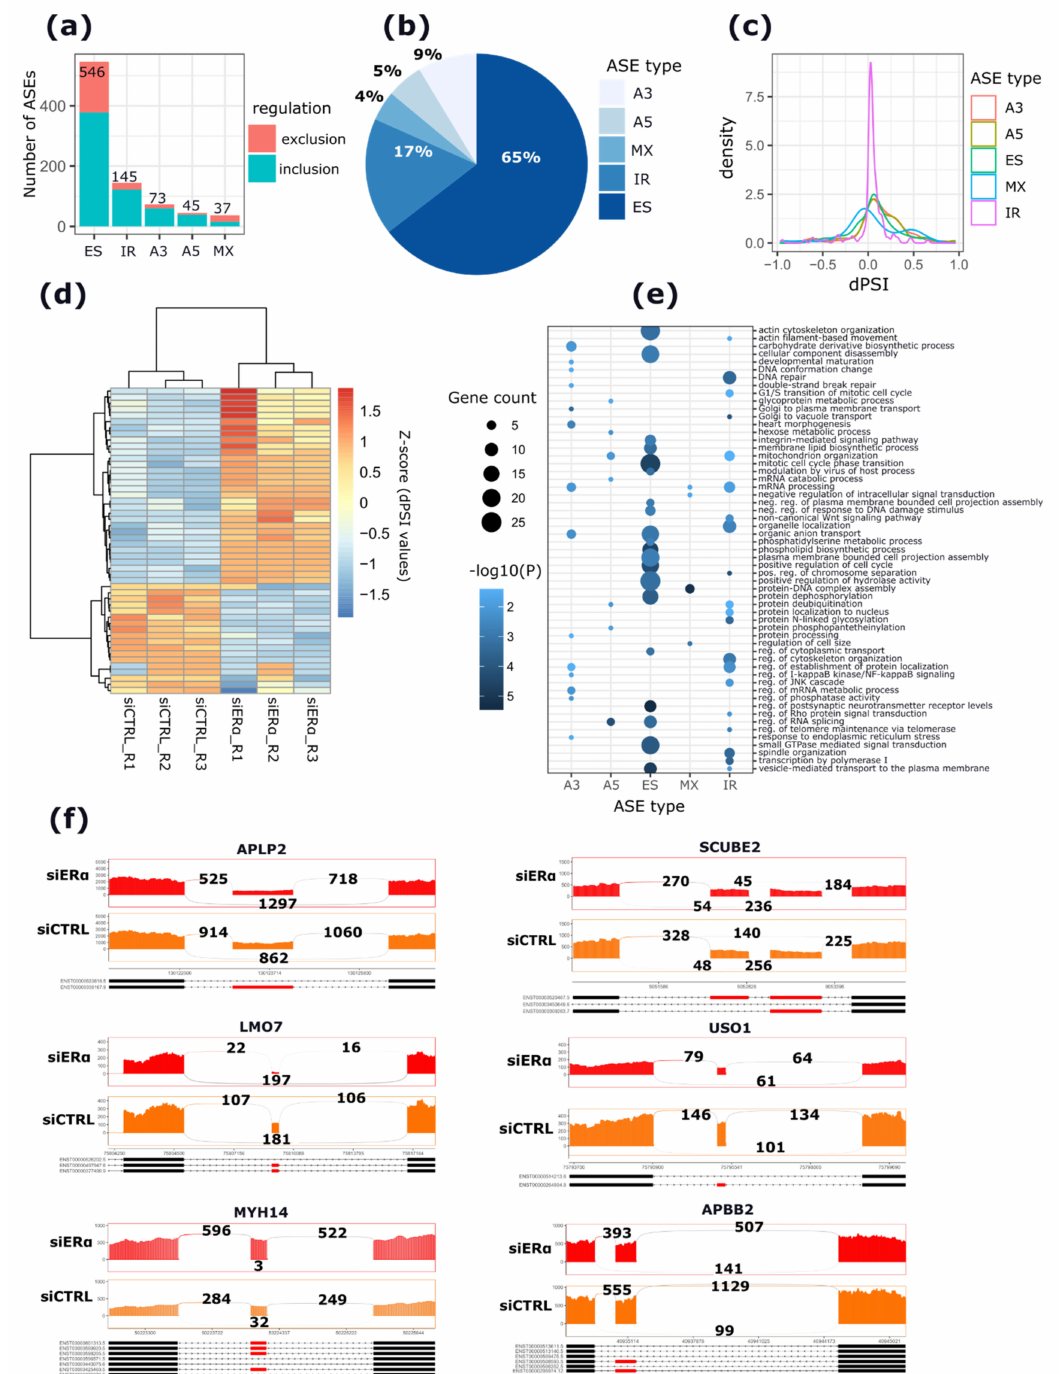
Figure 3. Overview of differential AS changes occurring upon apoER α depletion in MCF-7 cells. ( a ) Stacked bar plot representing the number of significant ASEs for each AS type. Red and cyan colors represent the number of included and repressed ASEs, respectively. ( b ) Pie-chart representing the percentage of ASE types. ( c ) Density plot representing the dPSI of the significant ASEs. ( d ) Heat map reporting the dPSI values of the top 50 significant ASEs. Color bar intensities are proportional to the inclusion level of each event (Z-score). ( e ) Dot plot representing the GO enrichment analysis of genes harboring significant ASEs. The x-axis represents the different ASE types. The size of the dots is proportional to the number of genes enriched in each GO term. The color of the dots is proportional to the significance of the enrichment ( − log10 (P)). ( f ) Sashimi plots for the six top significant ASEs. Alternative exons (in red) and their flanking constitutive exons involved in each event are reported. The numbers above junctions indicate the total number of reads supporting either inclusion or exclusion of the